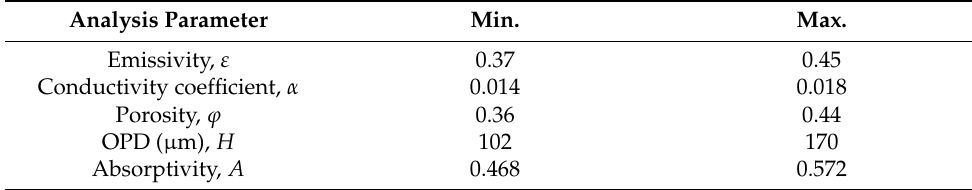
Table 4. Modified range of analysis parameters.